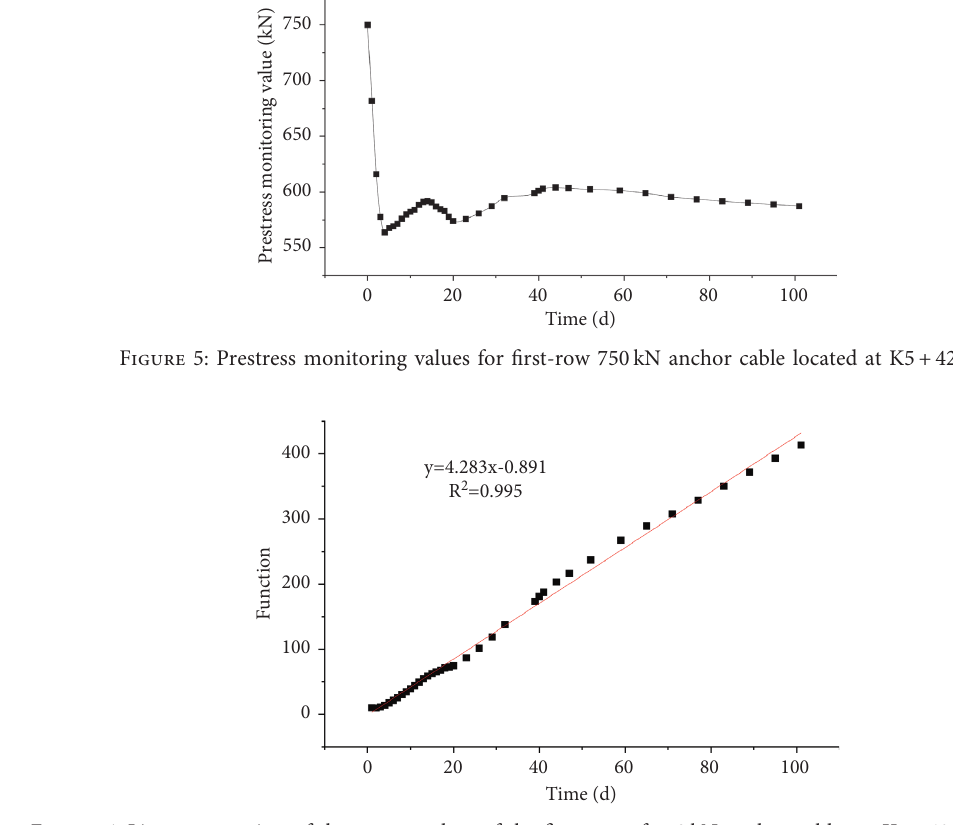
Figure 6: Linear regression of the prestress loss of the first row of 750kN anchor cables at K5 +420 over